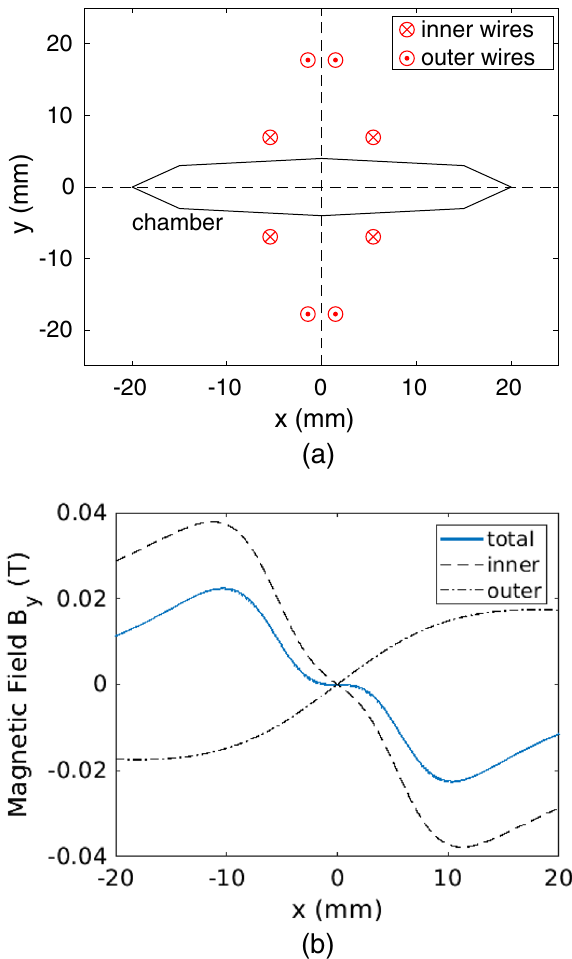
FIG. 1. The conductors geometry and the vertical magnetic field profile for an optimized ALS nonlinear kicker. (a) 8 current- driven conductors symmetrically located in four quadrants of a transverse plane. The inner and outer four conductors carry current in an opposite direction. (b) The vertical magnetic field is observed along the horizontal mid-plane. The blue solid line represents the total field contribution from 8 conductors, the dashed line represent the field contributions from the inner four conductors and the dash-dot line from the outer four